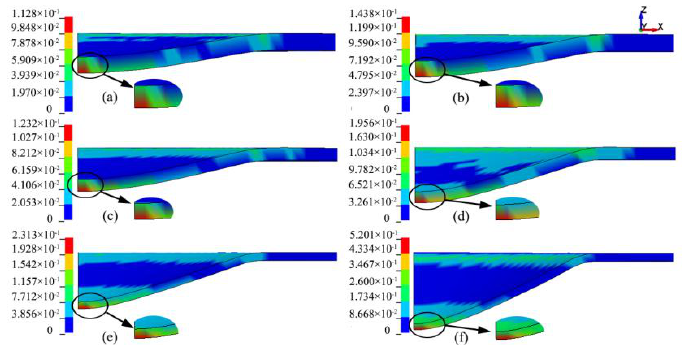
Figure 17. The equivalent plastic strain distribution of the micro bulging parts under different conditions: ( a ) 80 µ m, 565 mJ ( b ) 80 µ m, 835 mJ ( c ) 60 µ m, 565 mJ ( d ) 60 µ m, 835 mJ ( e ) 40 µ m, 565 mJ ( f ) 40 µ m, 835